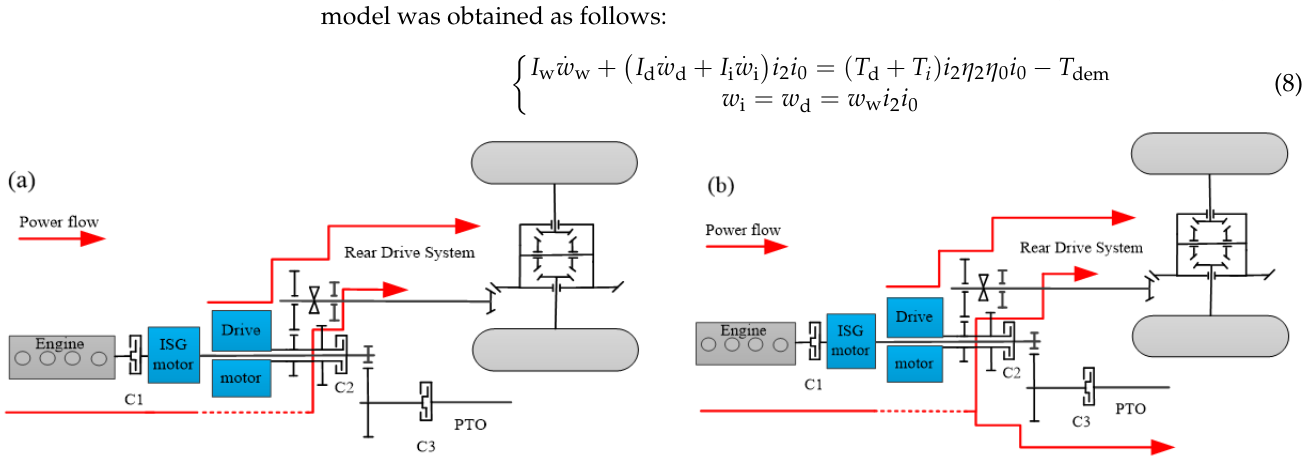
Table 1. The operation schedule of the dual-power system. Modes